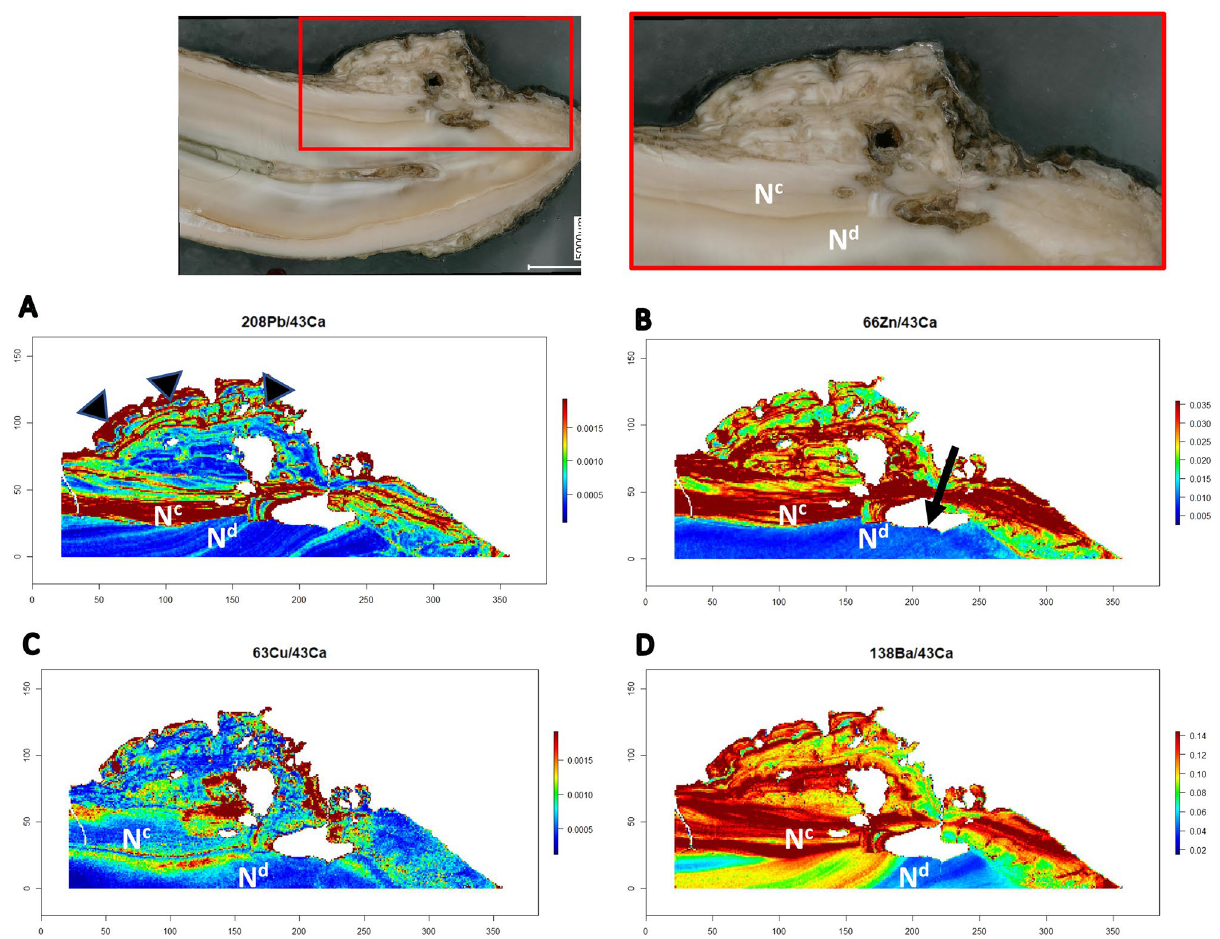
Figure 4. Elemental dysregulation in EOTRH. Maps of elemental distribution for hypercementosis lesions: lead ( A ), zinc ( B ), copper ( C ) and barium ( D ). Subsequent to establishing the distribution of trace elements in healthy unaffected tissue (Figs. 2 and 3), a region of hypercementosis (region outlined in red in top panels) was analyzed in the tooth shown in Figs. 1 and 2. Normal dentin marked with N d and regular cementum marked with N c . Incremental markings of irregular cementum shown with black arrowheads on lead map. Tooth resorption lesions noted with black arrow on zinc